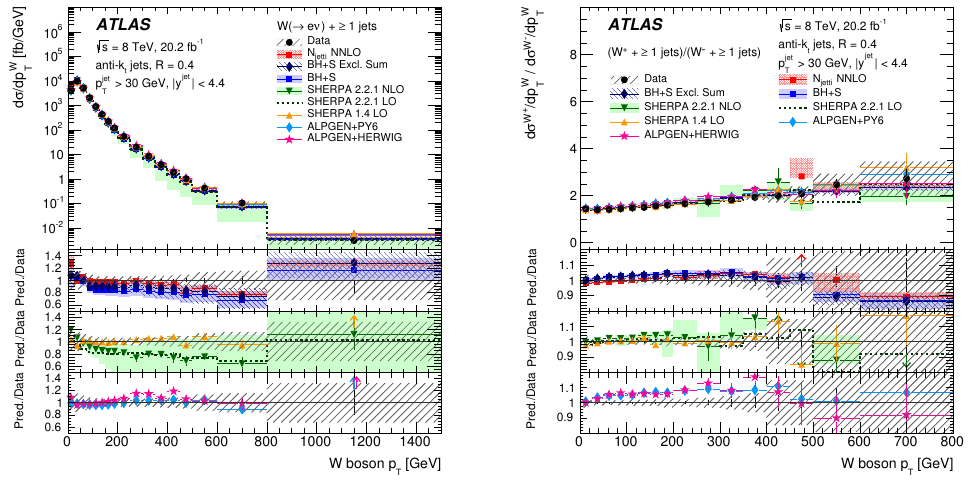
Figure 4 . Di(cid:11)erential cross sections for the production of W bosons (left) and the W + =W (cid:0) ratio (right) as a function of the W p T for events with N jets (cid:21) 1. The last bin in the left (cid:12)gure includes values beyond the shown range. For the data, the statistical uncertainties are indicated as vertical bars, and the combined statistical and systematic uncertainties are shown by the hatched bands. The uppermost panel in each plot shows the di(cid:11)erential cross sections, while the lower panels show the ratios of the predictions to the data. The theoretical uncertainties on the predictions are described in the text. The arrows on the lower panels indicate points that are outside the displayed